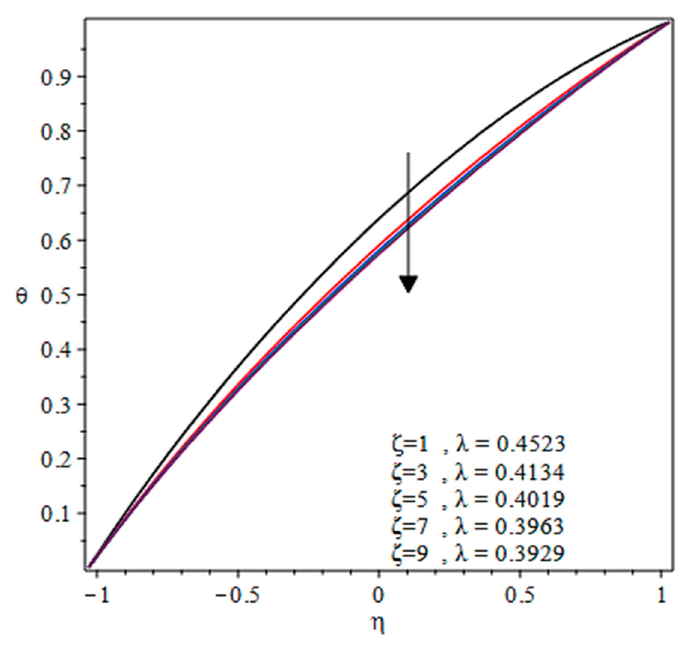
ζ ζ influence on the temperature distribution at influence on the temperature distribution at